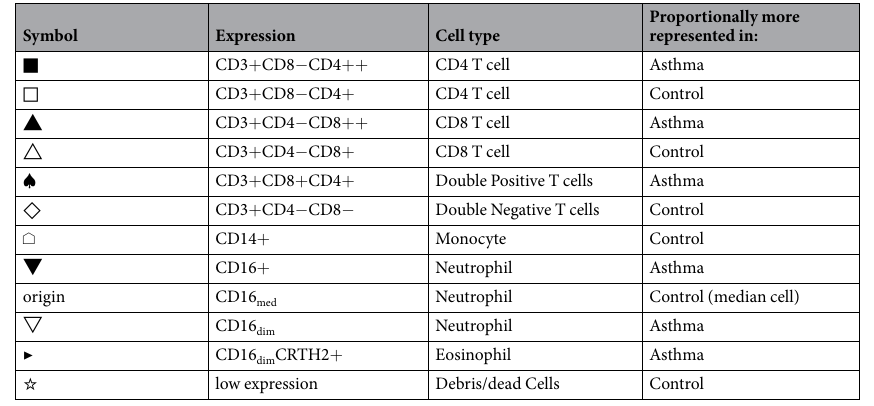
Table 1. Expression profile of the different areas marked with symbols in Fig. 5. The expression profiles are checked by conventional sequential two dimensional